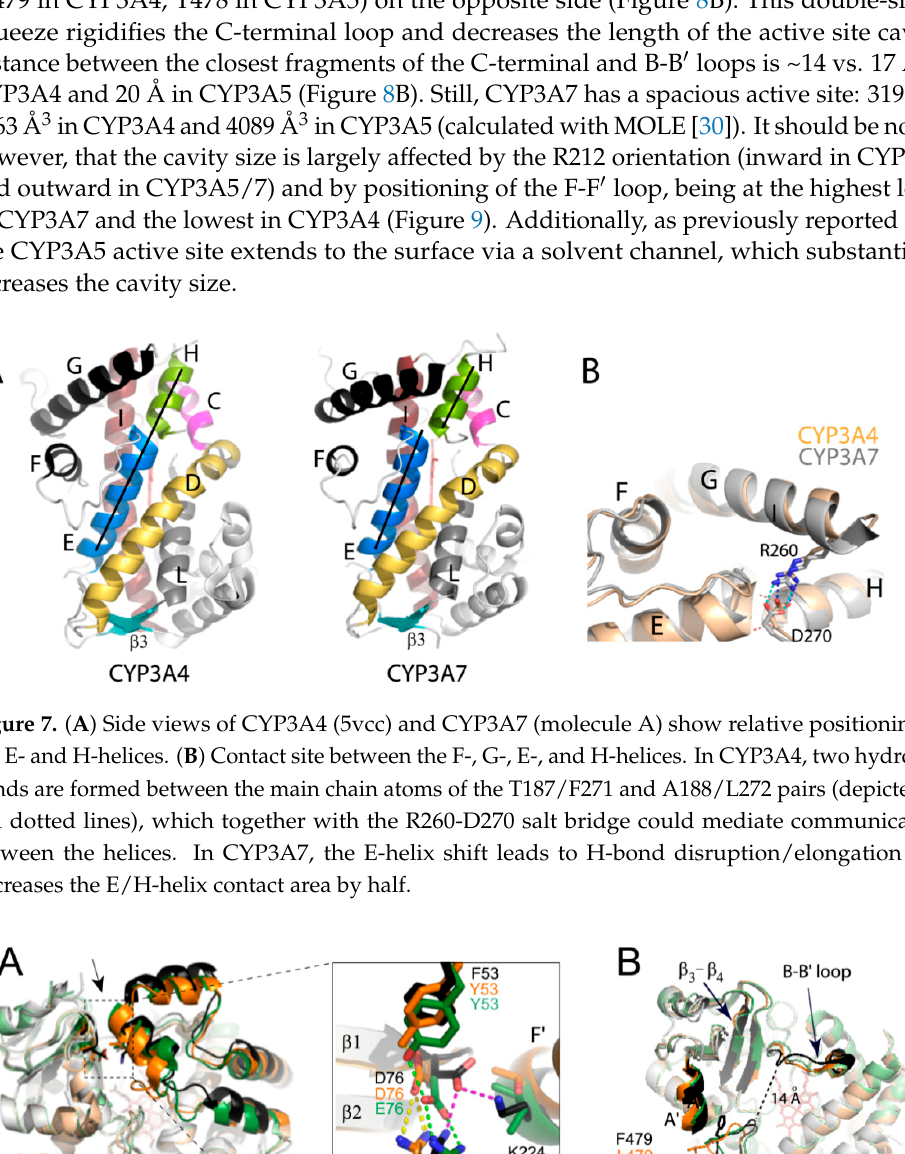
Figure 8. ( A ) General and magnified views at the substrate channel in CYP3A4 (5vcc; orange), CYP3A5 (6mjm; green), and CYP3A7 (molecule A; gray/black). The F-G segment and the β 1 – β 2 connecting loop are highlighted in brighter colors. Entrance to the substrate channel is indicated by an arrow. Due to Y53F and T/I224K substitutions in CYP3A7, its D76 establishes a different H-bonding network that links the opposite channel walls. ( B ) Because of distinct folding of the B-B ′ and C-terminal loops, the catalytic cavity in CYP3A7 is shaped differently and narrower than in CYP3A4/5. Elongation of the β 3 – β 4 strands further decreases plasticity of the active site. The F-G segment was removed for clarity.